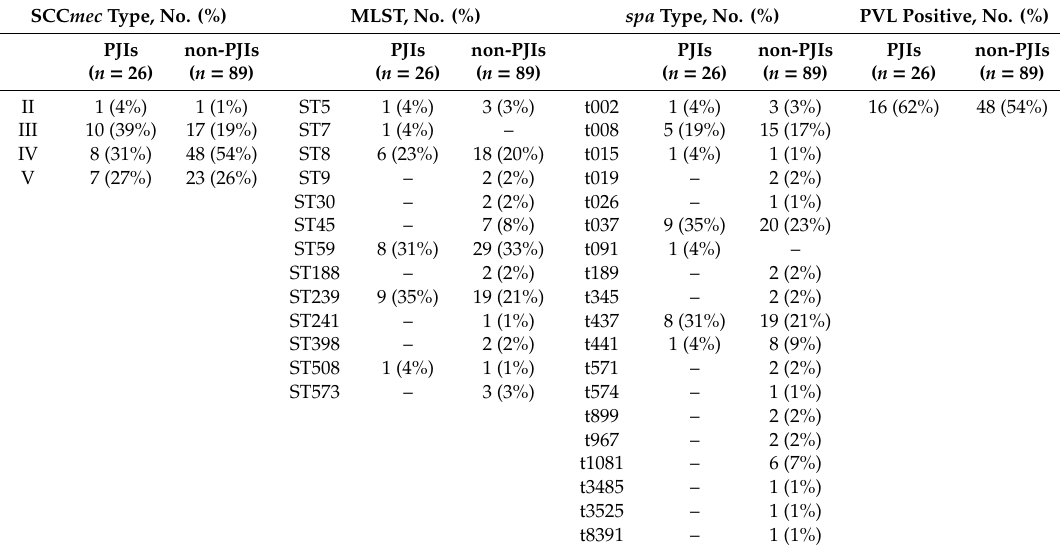
Table 11. Molecular genotyping analysis of OM-MRSA isolates from PJIs and non-PJIs. SCC mec Type, No.